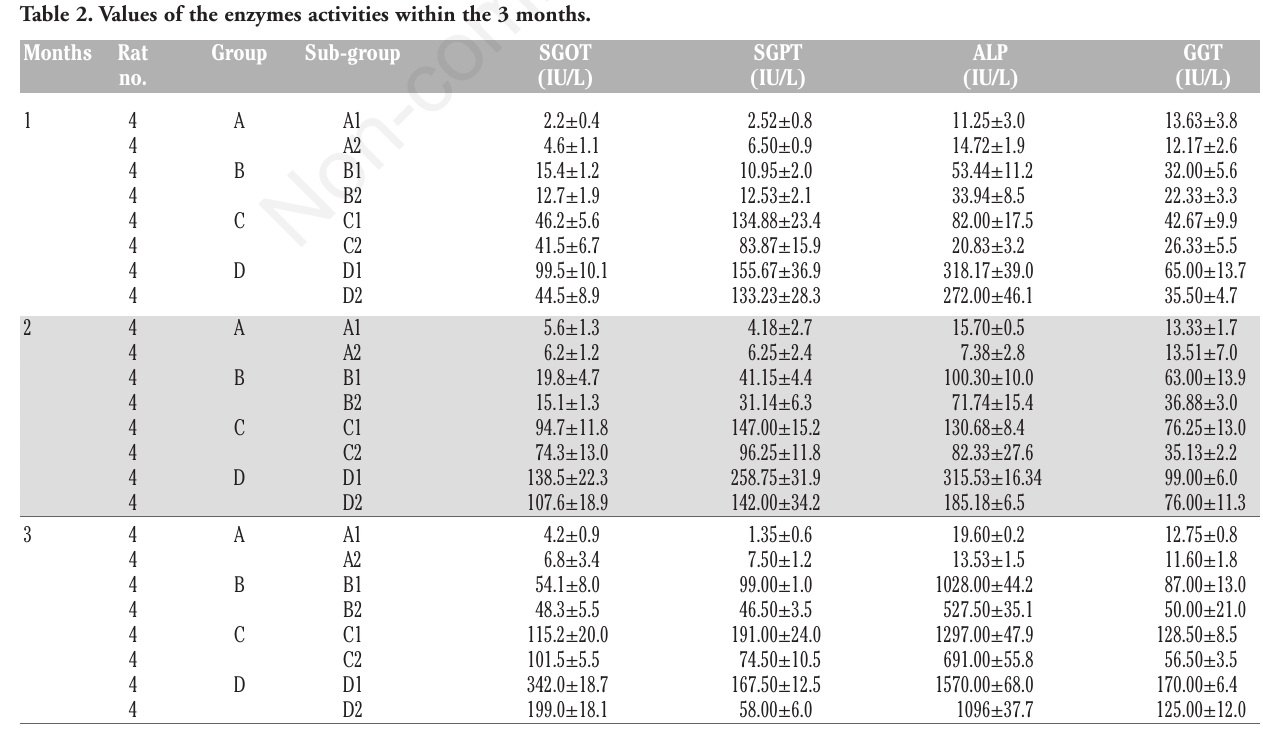
Table 2. Values of the enzymes activities within the 3